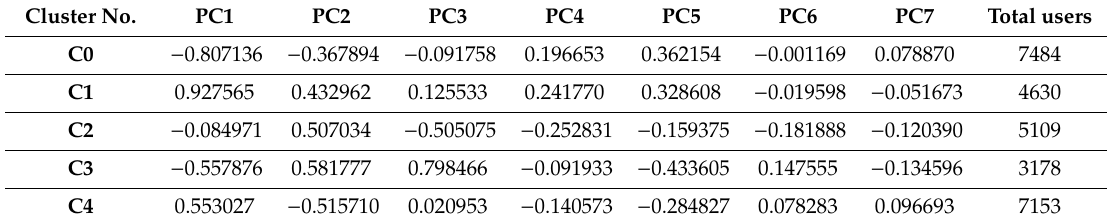
Table 1. K-means clusters with corresponding principal component (PC) values. Figure 6. Elbow and silhouette plots for choosing the number of clusters for K-means.